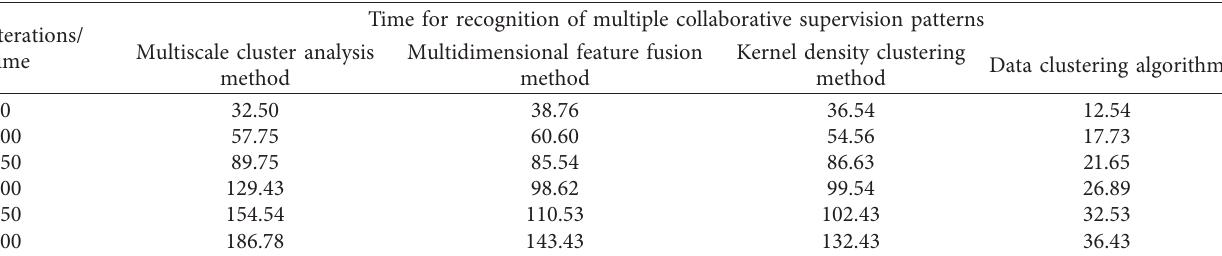
Table 2: Identification time of multiple collaborative supervision modes within social organizations.